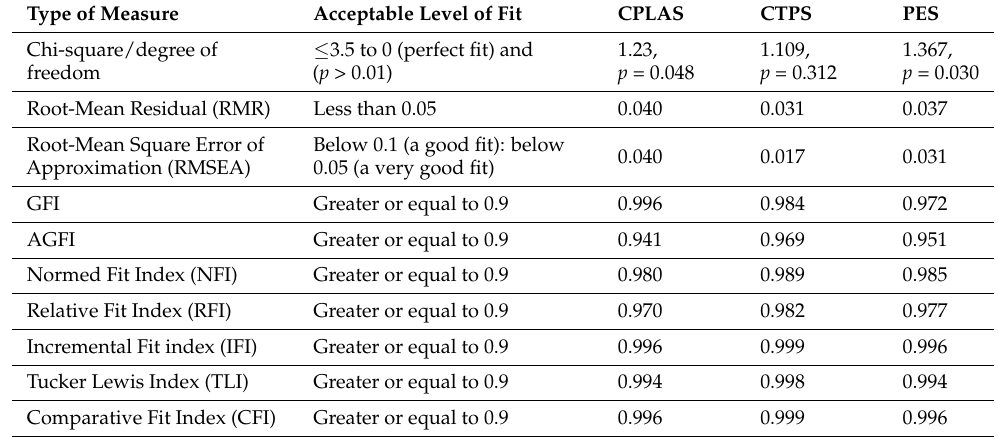
Table 1. Goodness-of-fit indices for CPLAS, CTPS, and PES.